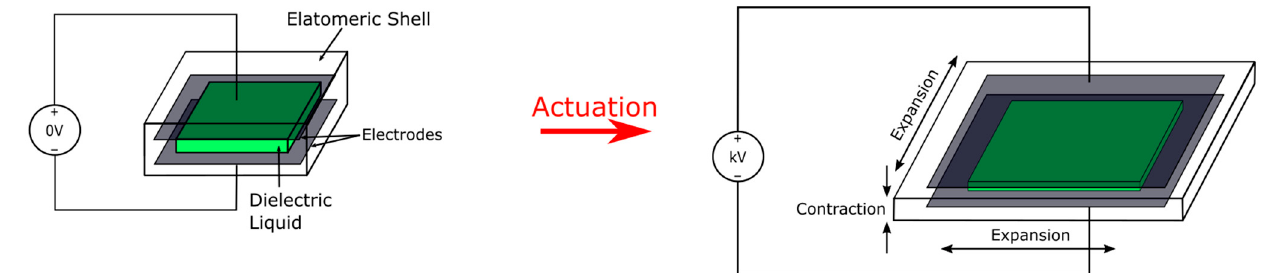
Figure 3. The actuation scheme of a typical elastomeric HASEL. Similar to a sandwich-structured DEA, an elastomeric HASEL requires high voltage (kV range) to actuate, and the actuation scheme is also planar expansion + linear contraction. The dielectric liquid core has a much lower Young’s modulus than the elastomer core of a DEA, thus making a similarly shaped elastomeric HASEL have higher actuation strain under the same actuation conditions (i.e., applied voltage and pre- straining).